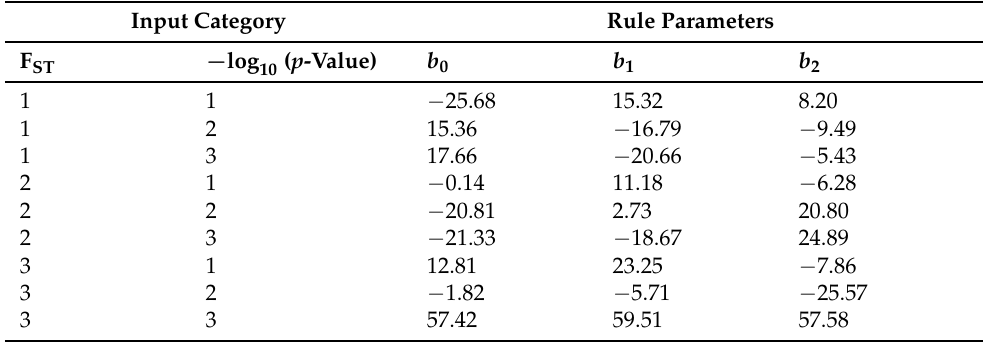
Table 1. Fuzzy rules and corresponding rule